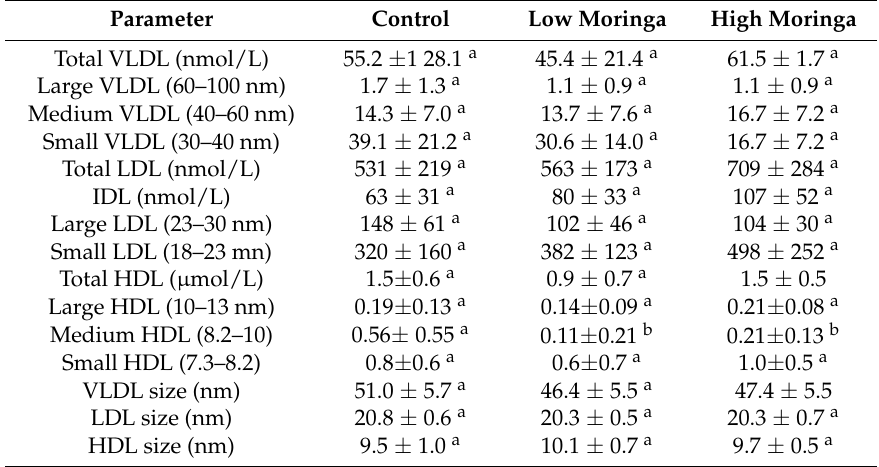
Table 2. Lipoprotein subfractions in guinea pigs fed a hypercholesterolemic diet with no Moringa (control), Low (10%), or High Moringa (15%) 1